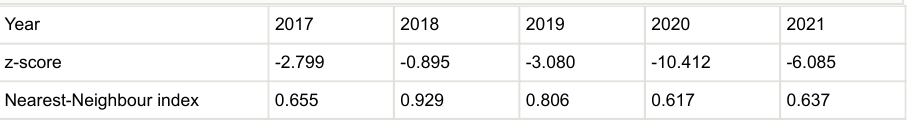
Results of the aggregation analysis of the European ground squirrel's holes mapped in the period 2017-2021 show significant aggregation for each year - the Nearest-Neighbour index is smaller than 1 and the z-score values are